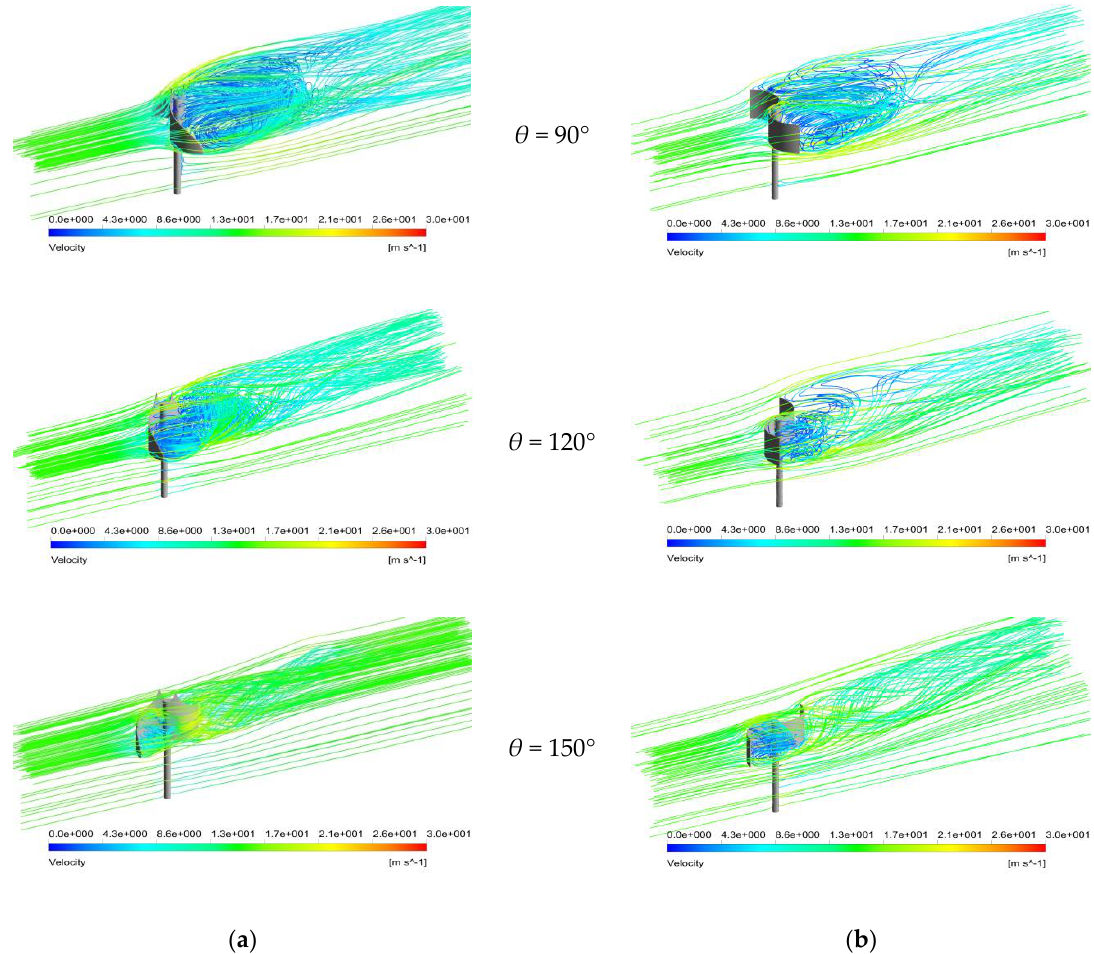
Figure 19. Air flow velocity streamlines at an air velocity of 15.8 m/s around ( a ) the IceWind turbine and ( b ) the Savonius wind turbine.